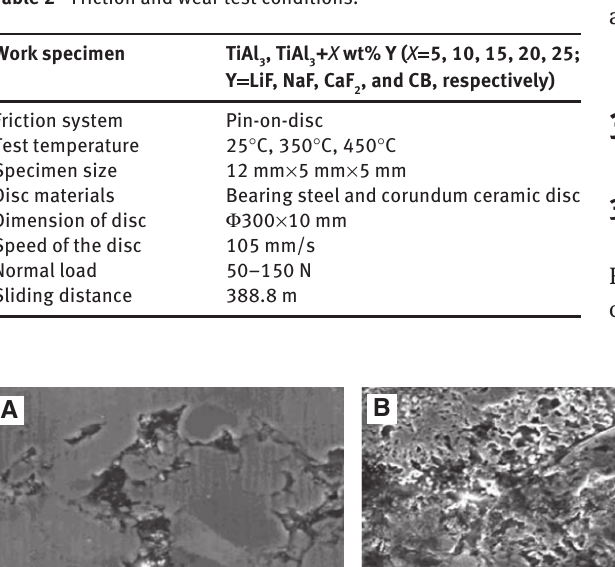
Table 2 Friction and wear test conditions.